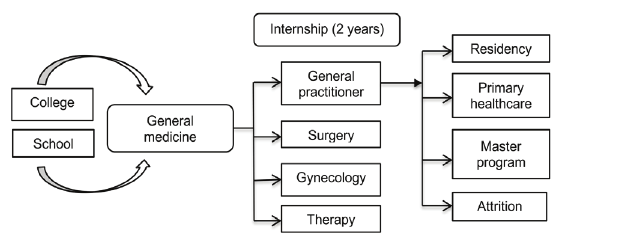
Figure 2 - Medical education system in Kazakhstan